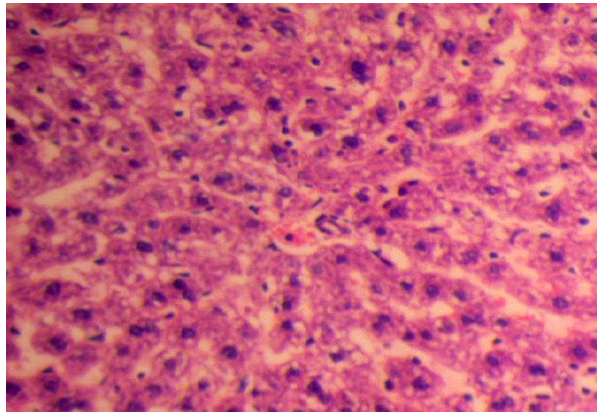
Fig. 7. Rat liver, which on the background of ethyl alco- hol was injected WSPC of plum fruit. Diffuse vacuola- tion of hepatocytes. Hematoxylin-eosin. ×200 Comparison drug silibor also did not prevent the occurrence of fatty dystrophy of hepatocytes in rats with alcoholic loading. The expressiveness of changes was practically at the level of the last (Fig. 9, 10). Thus, a light-optical study showed that after 7–10 days of administration of 40 ml of ethyl alcohol in rats at a dose of 7 ml / kg in the rats liver, morphological signs of parenchymal fatty degeneration appeared, which may be the very initial stage of alcoholic hepatopathy devel-